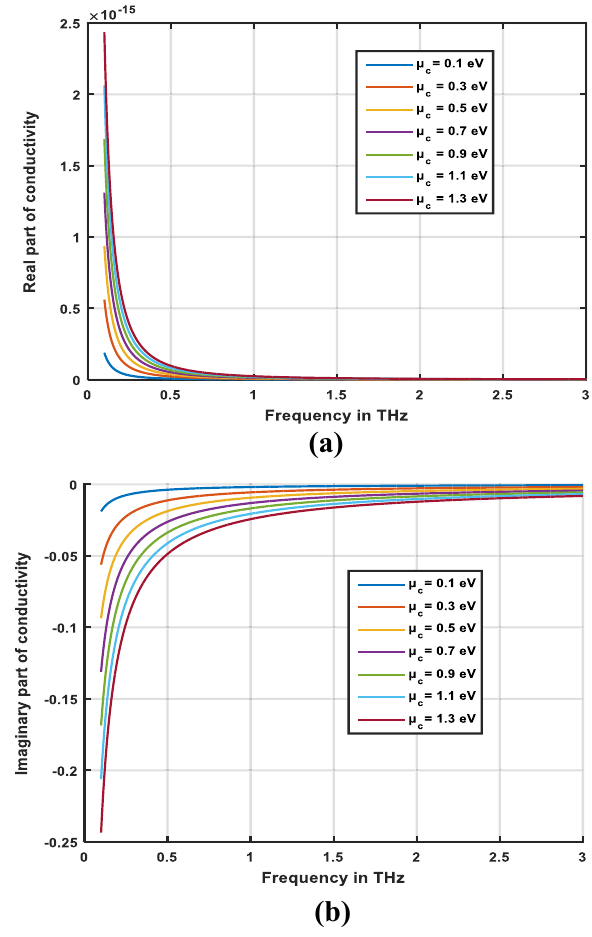
Fig. 2 Conductivity of the graphene using Kubo model a real part of conductivity b imaginary part of